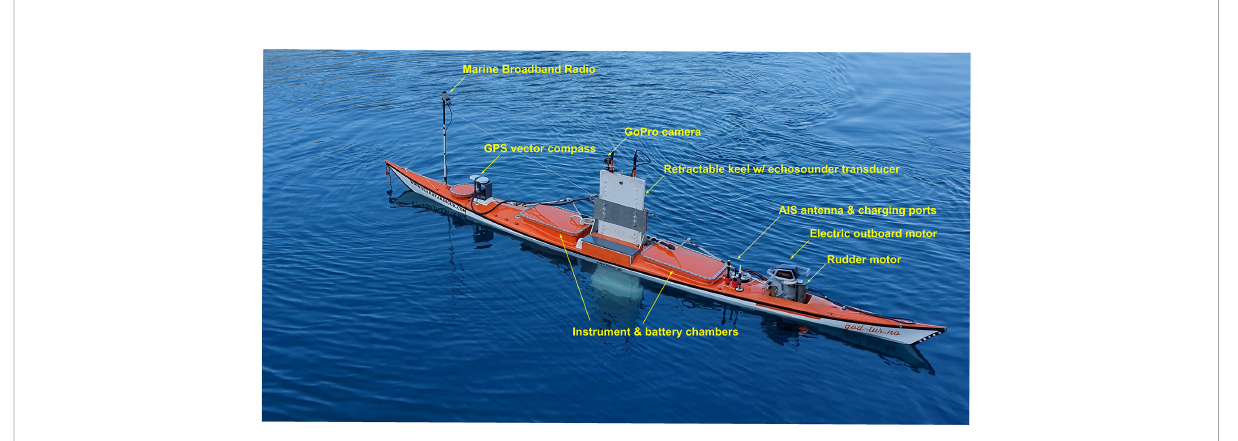
FIGURE 1 The Kayak Drone with the key external